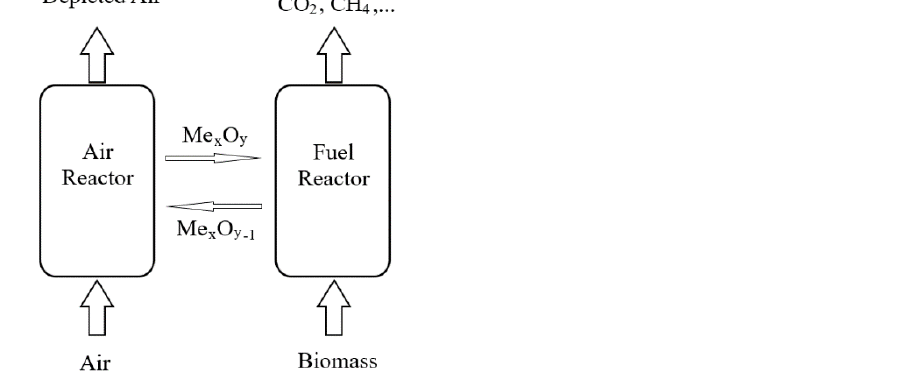
Figure 1. Schematic principles of Biomass chemical looping gasification process .